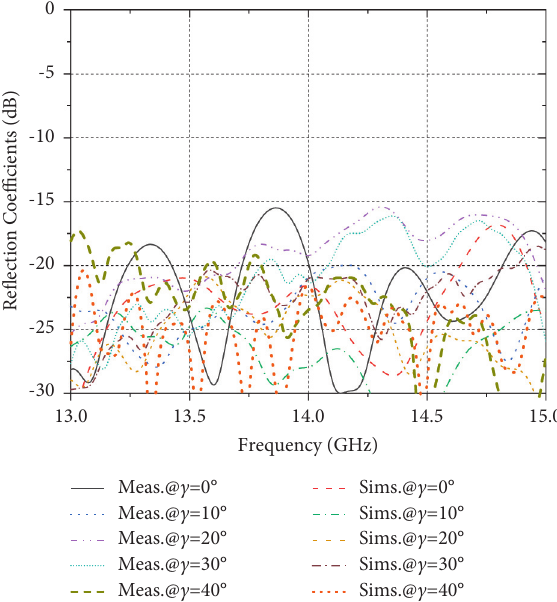
Figure 8: Simulation and measurement of the reflection coefficient of the input